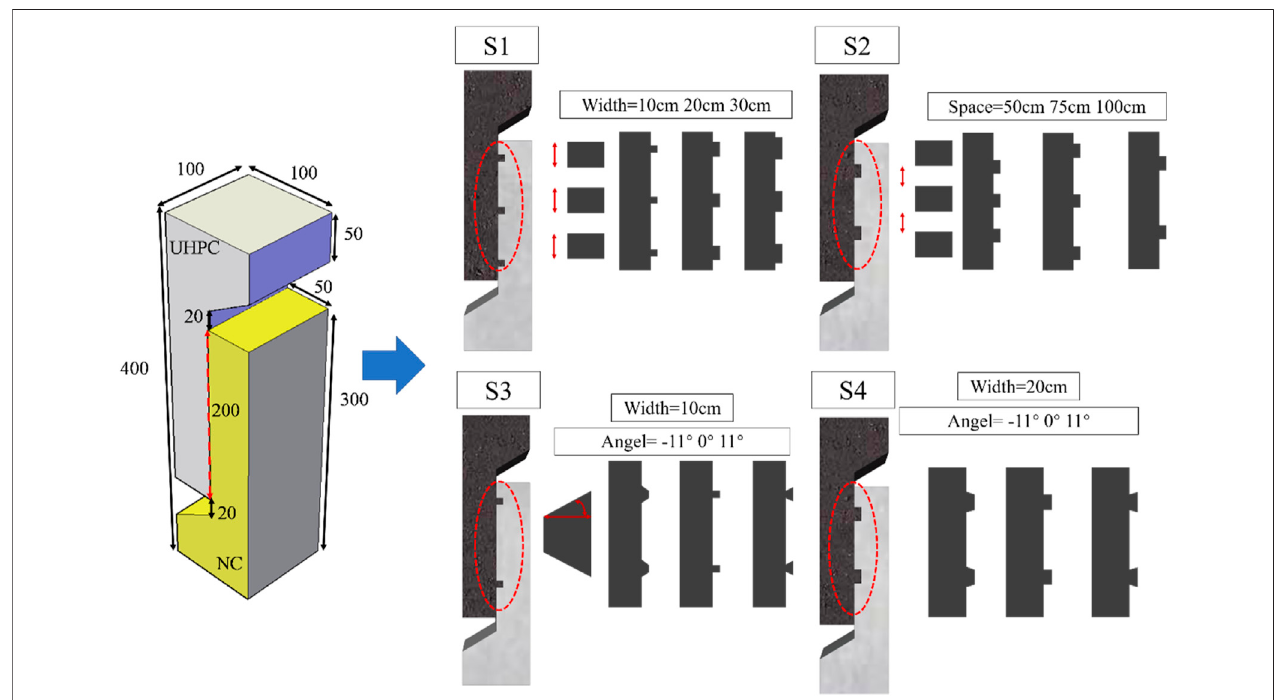
FIGURE 1 | Details of UHPC – NC push-off specimens.